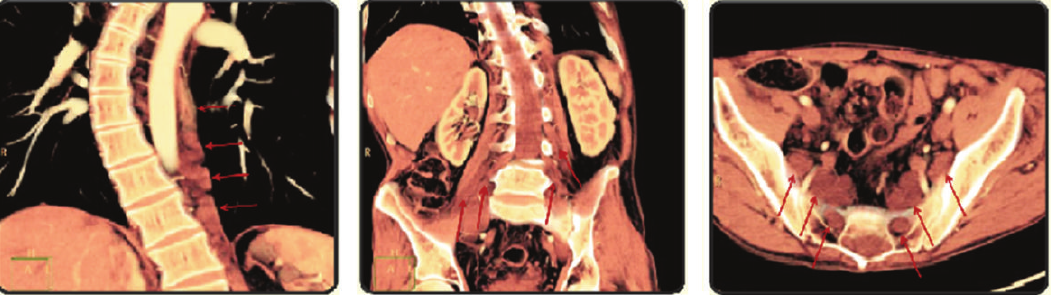
Figure 1: Abdominal CT scan showing